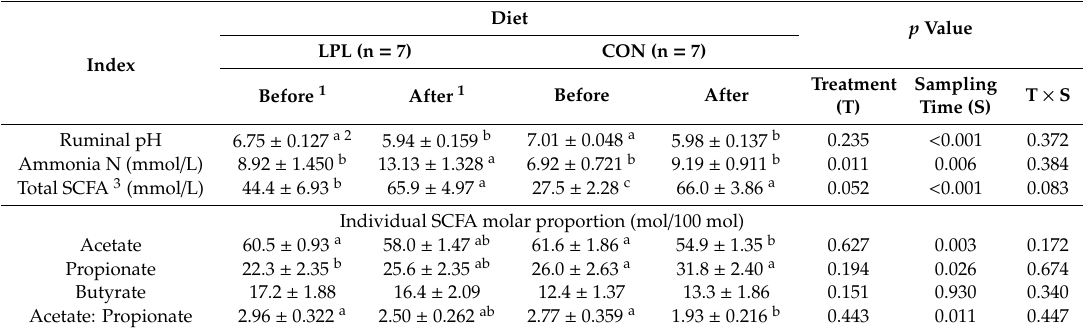
Table 4. Ruminal fermentation parameters of fattening lambs (n = 7) fed experimental diets supplemented with (LPL) or without (CON) lysophospholipids.